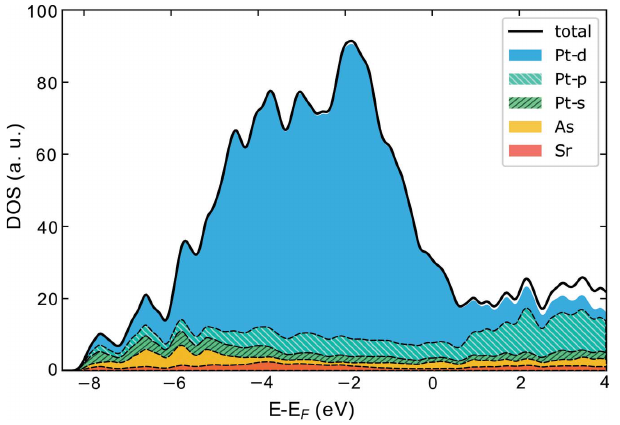
Figure 5 DOS calculated using DFT for the commensurate superstructure approximation, showing the contribution of each ion and Pt atomic orbital in a different colour. The high value of DOS at E F indicates the metallic character of the compound.